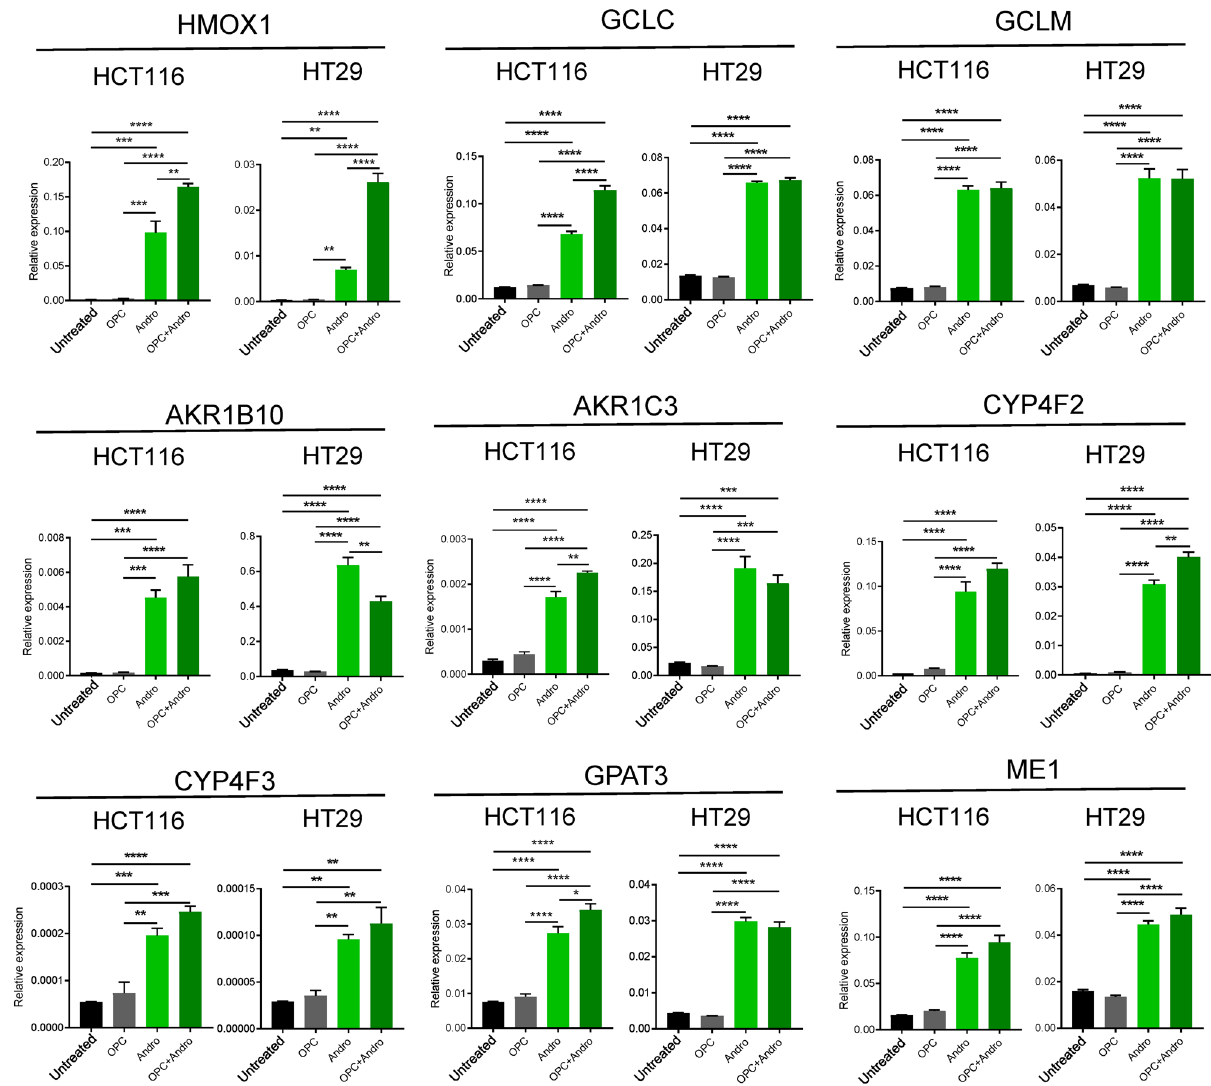
Figure 4. Andrographis up-regulates metabolic pathway and ferroptosis-related genes in CRC cells. Alterations in mRNA expression of metabolic pathway and ferroptosis-related genes viz. HMOX1, GCLC, GCLM, AKR1B10, AKR1C3, CYP4F2, CYP4F3, GPAT3 and ME1 following andrographis, OPCs, and the combination treatment for 16 h in HCT116 and HT29 cells. Statistical Significance is as follows: *P < 0.05, **P < 0.01, ***P < 0.001, and ****P < 0.0001 by one-way ANOVA